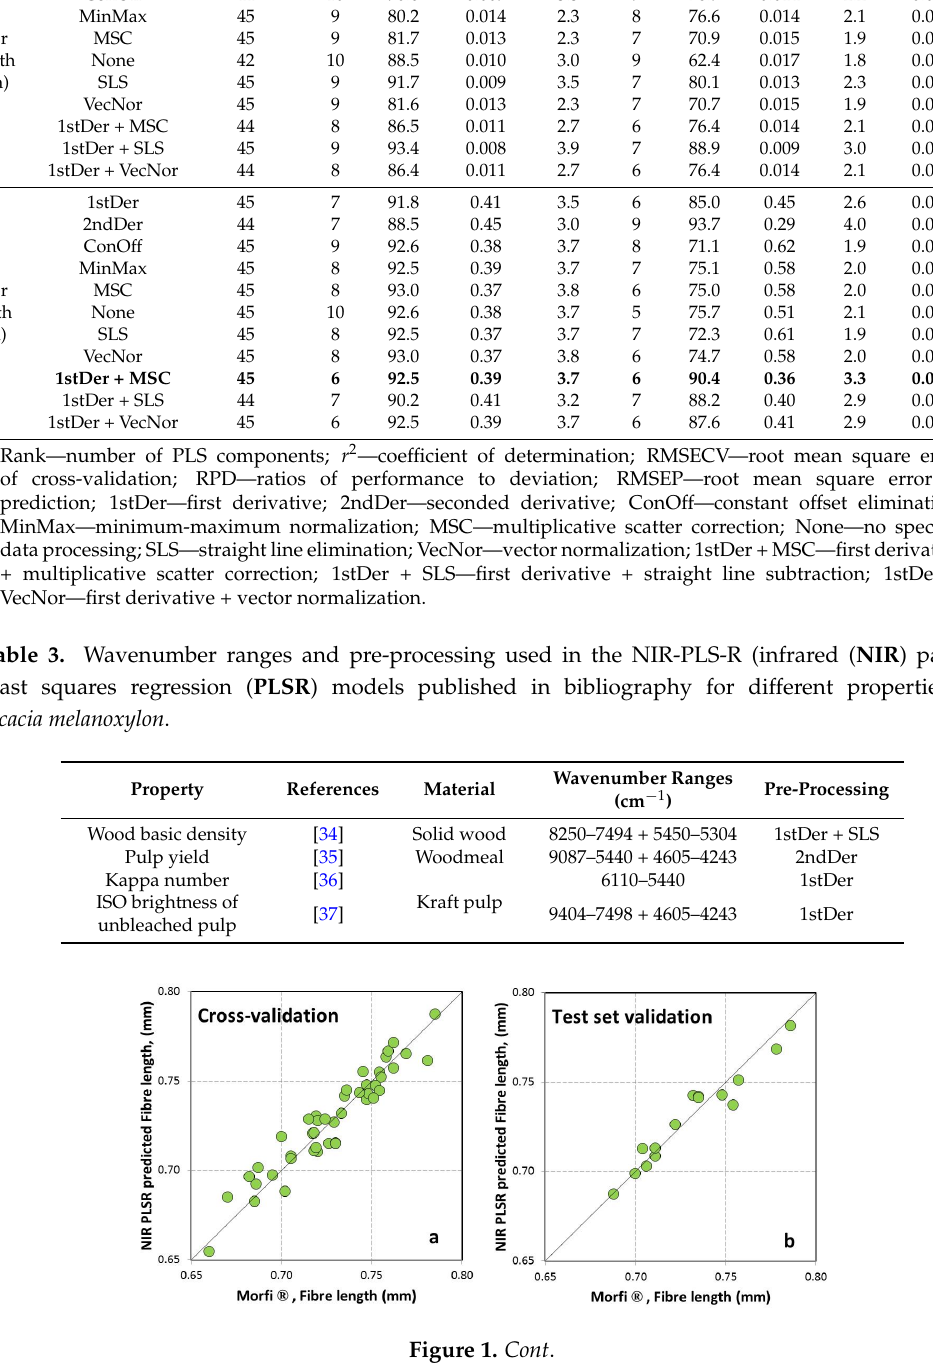
Figure 1. NIR ‐ PLS ‐ R predicted versus laboratory determined fiber length and fiber width for Acacia melanoxylon pulps for the cross ‐ validation ( a , c ) and test set validation ( b , d ).